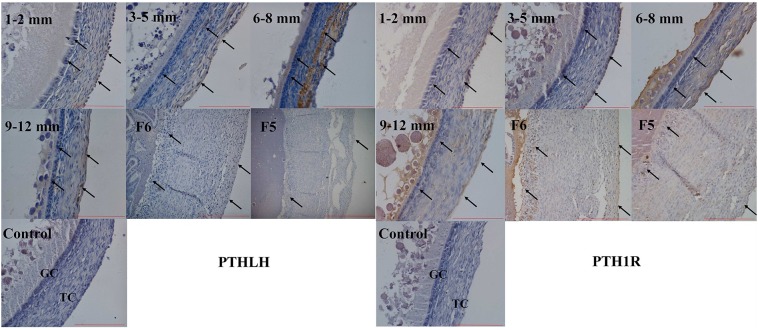
Localization of chicken PTHLH and PTH1R protein in the theca cells (TCs) and granulosa cells (GCs) of chicken follicles around follicle selection. Negative control with PBS used in place of primary antibody. Arrowheads indicate the position of stained protein. Redlines indicate 100 μm.